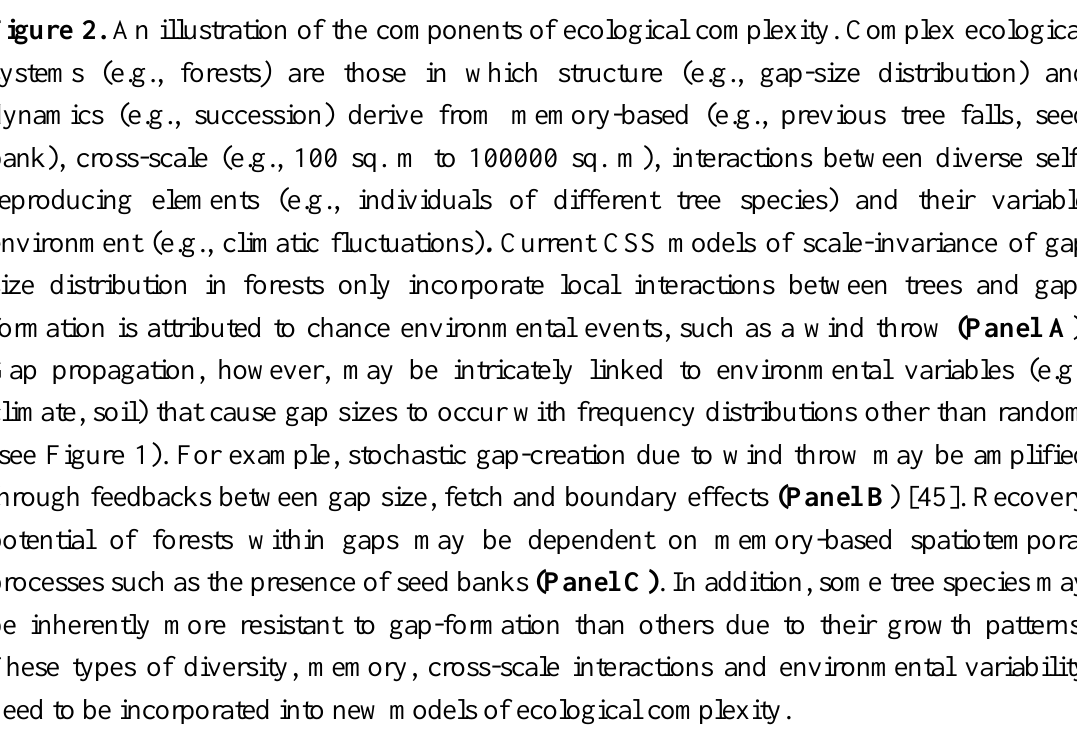
Figure 2. An illustration of the components of ecological complexity. Complex ecological systems (e.g., forests ) are those in which structure (e.g., gap-size distribution) and dynamics (e.g., succession) derive from memory-based (e.g., previous tree falls, seed bank), cross-scale (e.g., 100 sq. m to 100000 sq. m), interactions between diverse self- reproducing elements (e.g., individuals of different tree species) and their